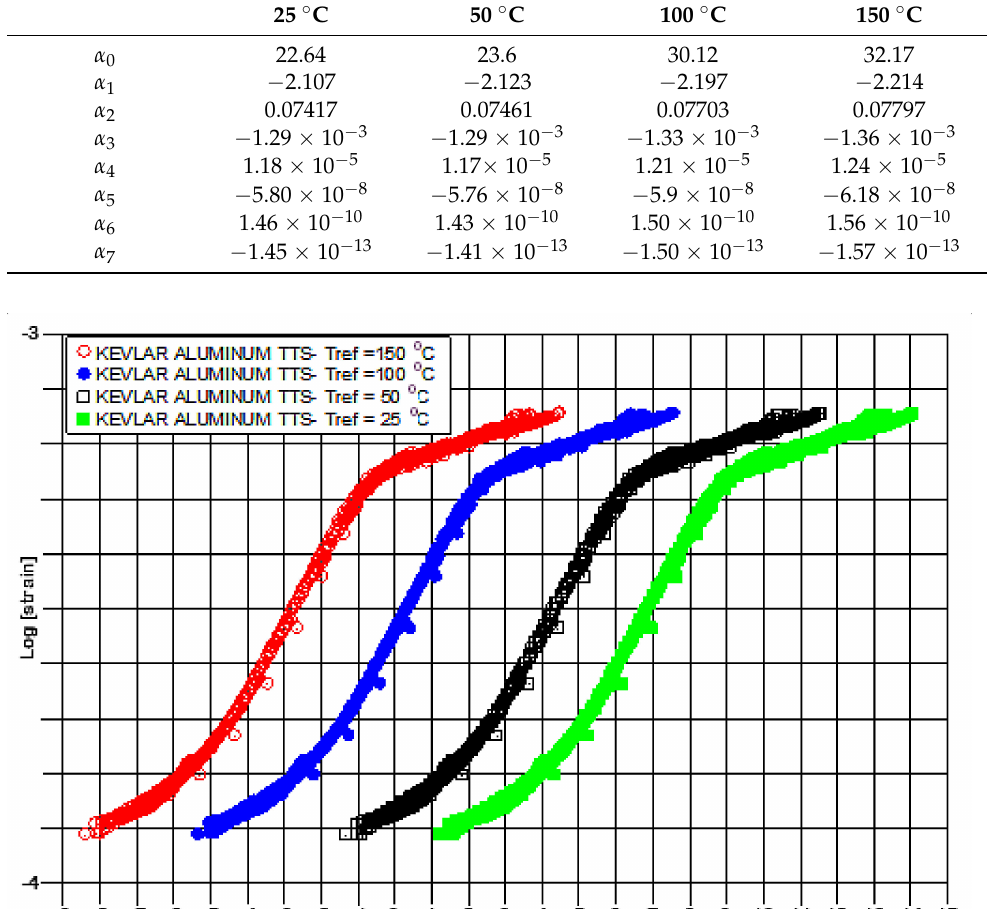
Table 3. Polynomial simulation factors for the shift curve a(T) at different reference temperatures for the Kevlar/Aluminum–glass composite hybrid creep TTS specimens.